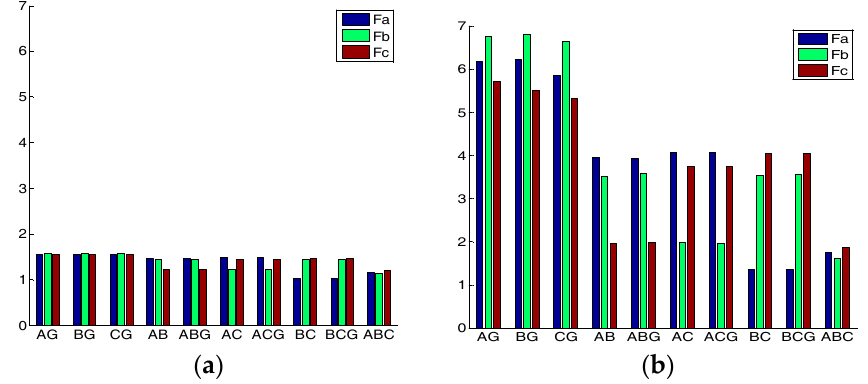
Figure 3. Fault feature histogram of the 10 types of short circuit faults by using ( a ) the traditional box dimension; and ( b ) the improved box dimension.